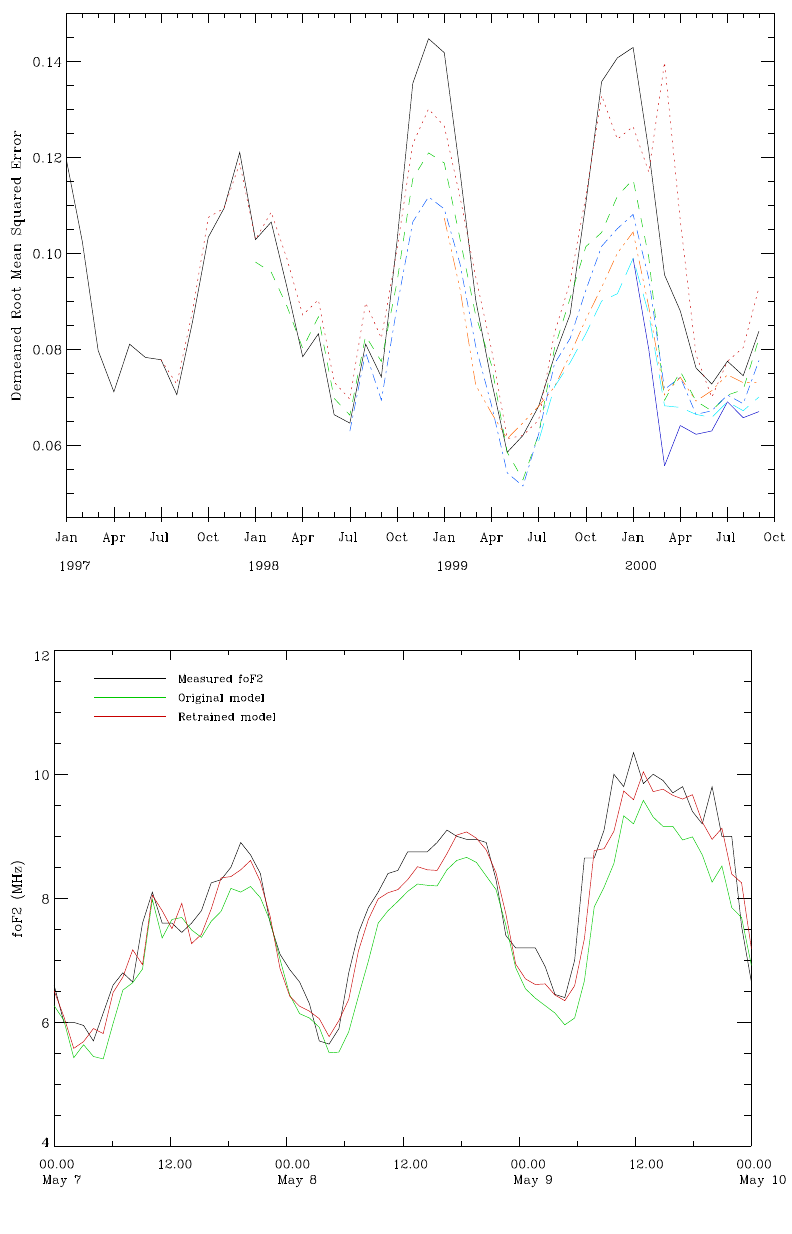
Fig. 7. Measured fo F2 and 1-hour ahead forecasts from original and re- trained models for the time period 7–9 May